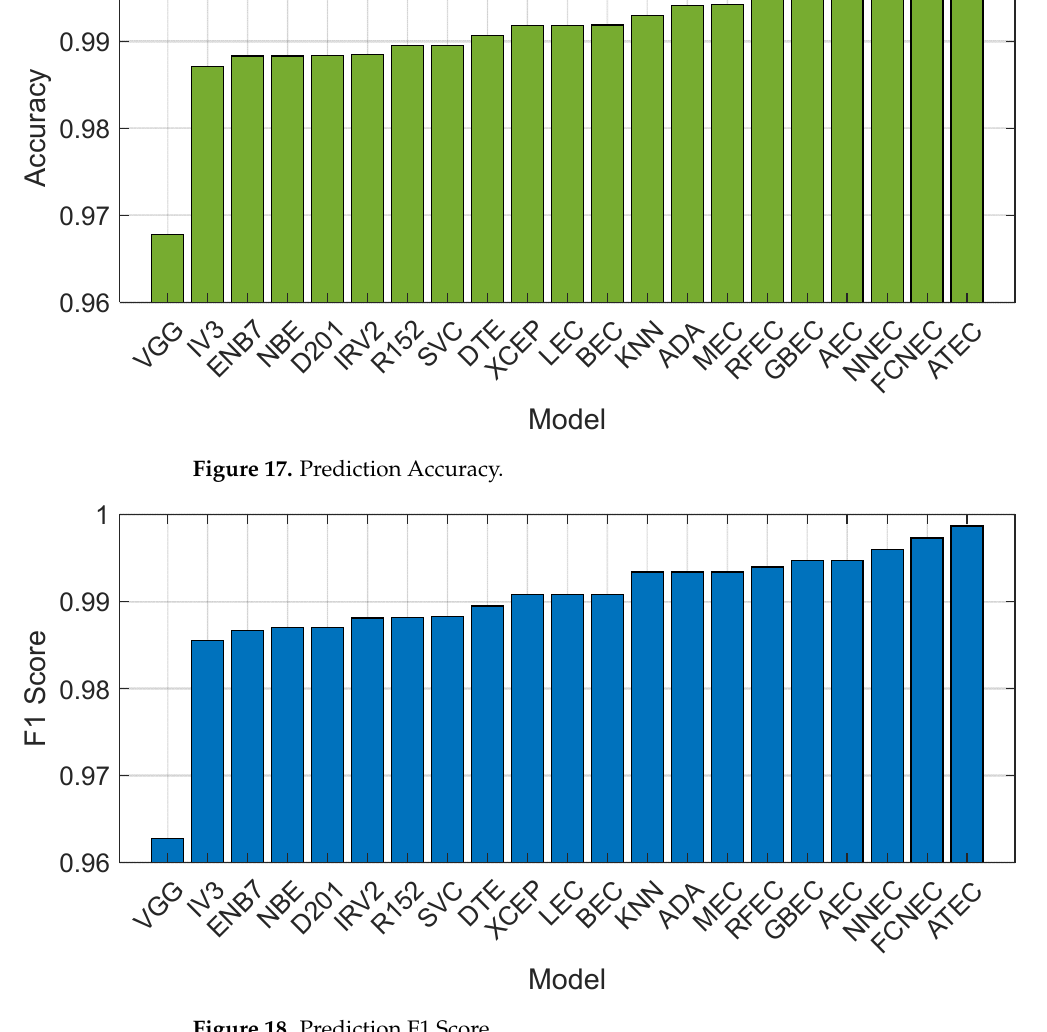
Figure 18. Prediction F1 Score.